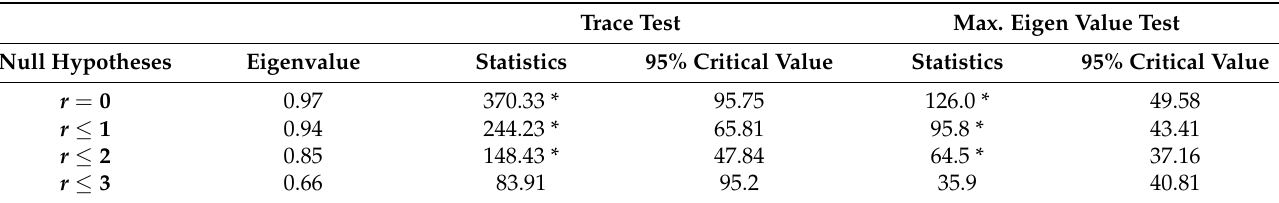
Table 4. Results for Johansen cointegration